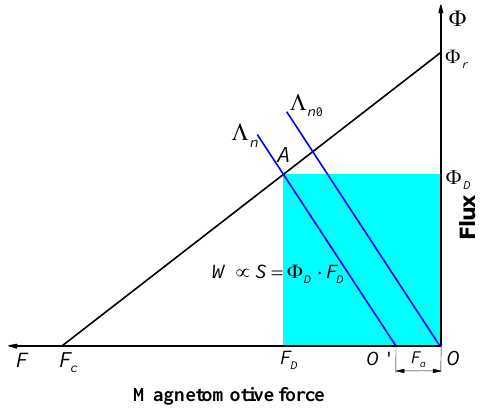
Figure 3. The PM working diagram.